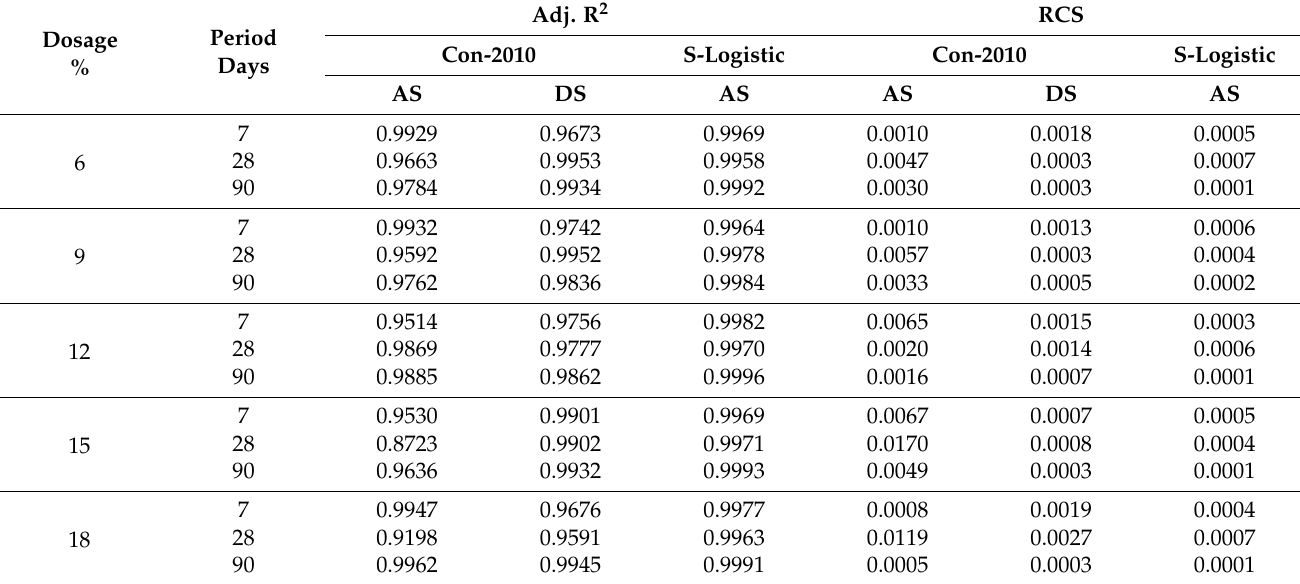
Table 4. The fitting degree of parameters calculated by the two constitutive